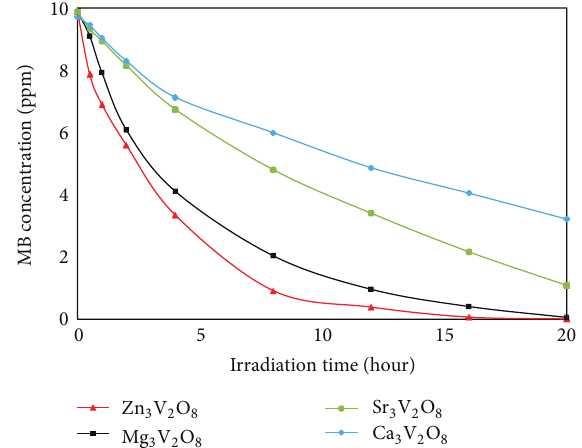
Figure 10: Photocatalytic MB degradation under tungsten-halogen light irradiation over M 3 V 2 O 8 (M = Zn, Mg, Sr, and Ca) phosphors. was in the order combustion > hydrothermal > sol-gel >